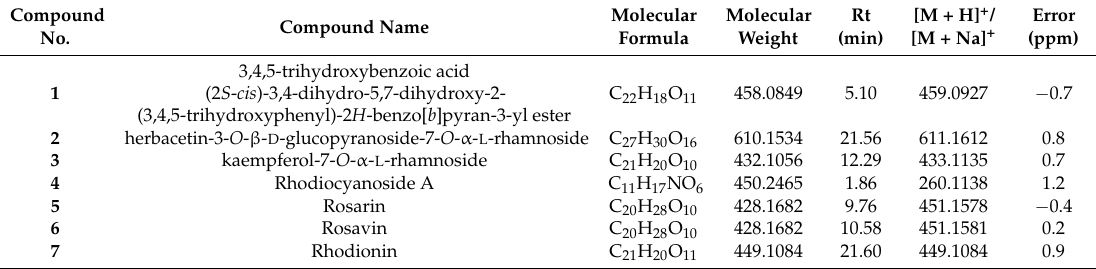
Table 3. The retention time (Rt) and mass (MS) characteristics of the main detected peaks in extracts of Rhodiola rosea L. Compound No.